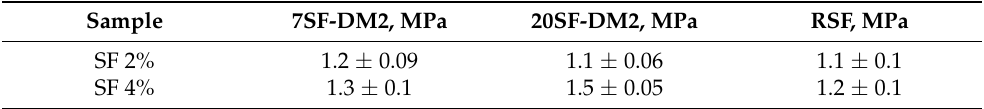
Table 3. Compressive moduli of sponges fabricated from (A) 2% ( w / v ) and (B) 4% ( w / v ) of 7SF-DM2, 20SF-DM2, and RSF